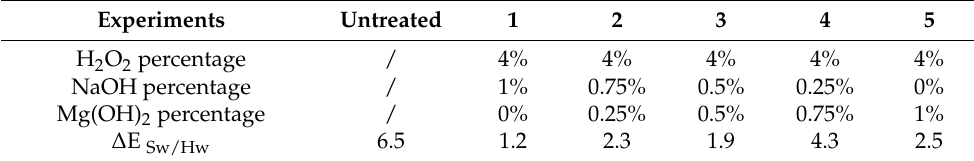
Table 4. ∆ E evolution depending on NaOH/Mg(OH) 2 ratio during H 2 O 2 treatment.